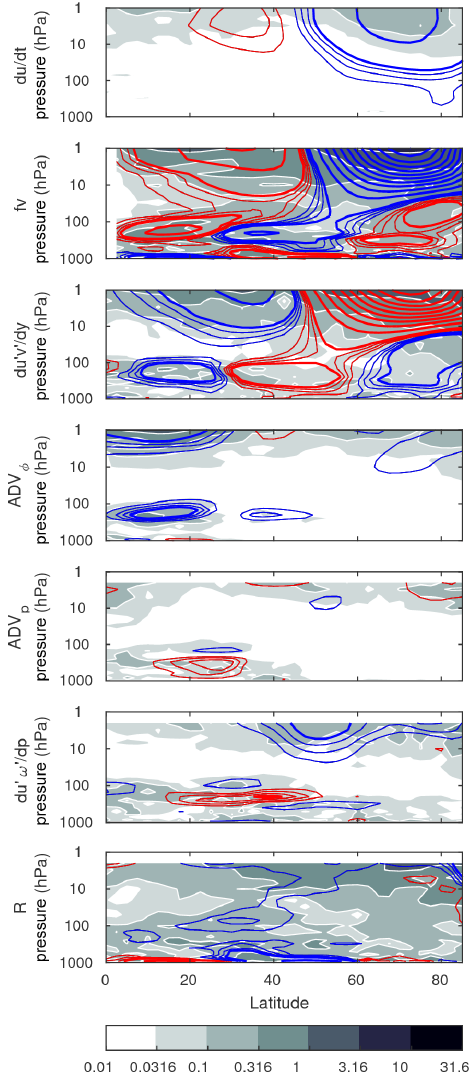
Figure 7. Pressure–latitude cross section of inter-reanalysis mean terms of the momentum equation averaged from lags − 5 to 0 days during SSW events. Composite mean is shown with red or blue for positive or negative values, with a contour interval of 0.25 for values ranging from 0.5 to 1.5 with thin contours and intervals of 2.5 ranging from 2.5 and larger with thick contours. The inter- reanalysis standard deviation is shaded per the color bar. All quan- tities are shown for the LRE members and are expressed in units of ms − 1 day − 1